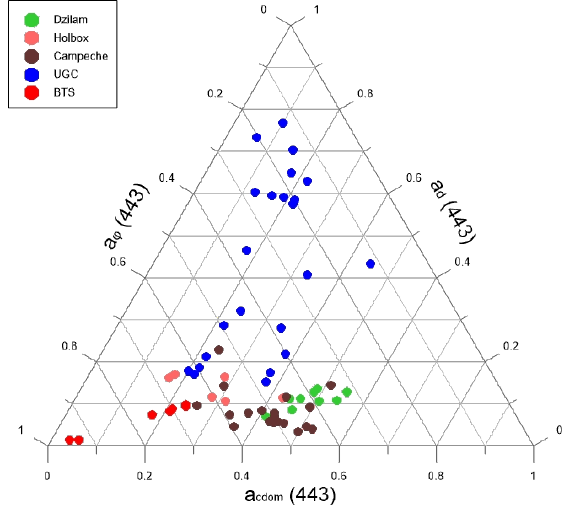
Figure 4. Triangular diagram used to classify sampling points according to the contribution to 𝑎(443) of each component: phytoplankton (𝑎  ( 443 ) ), colored dissolved organic matter (𝑎 𝑐𝑑𝑜𝑚 ( 443 ) ) and detritus ( 𝑎 𝑑 (443)